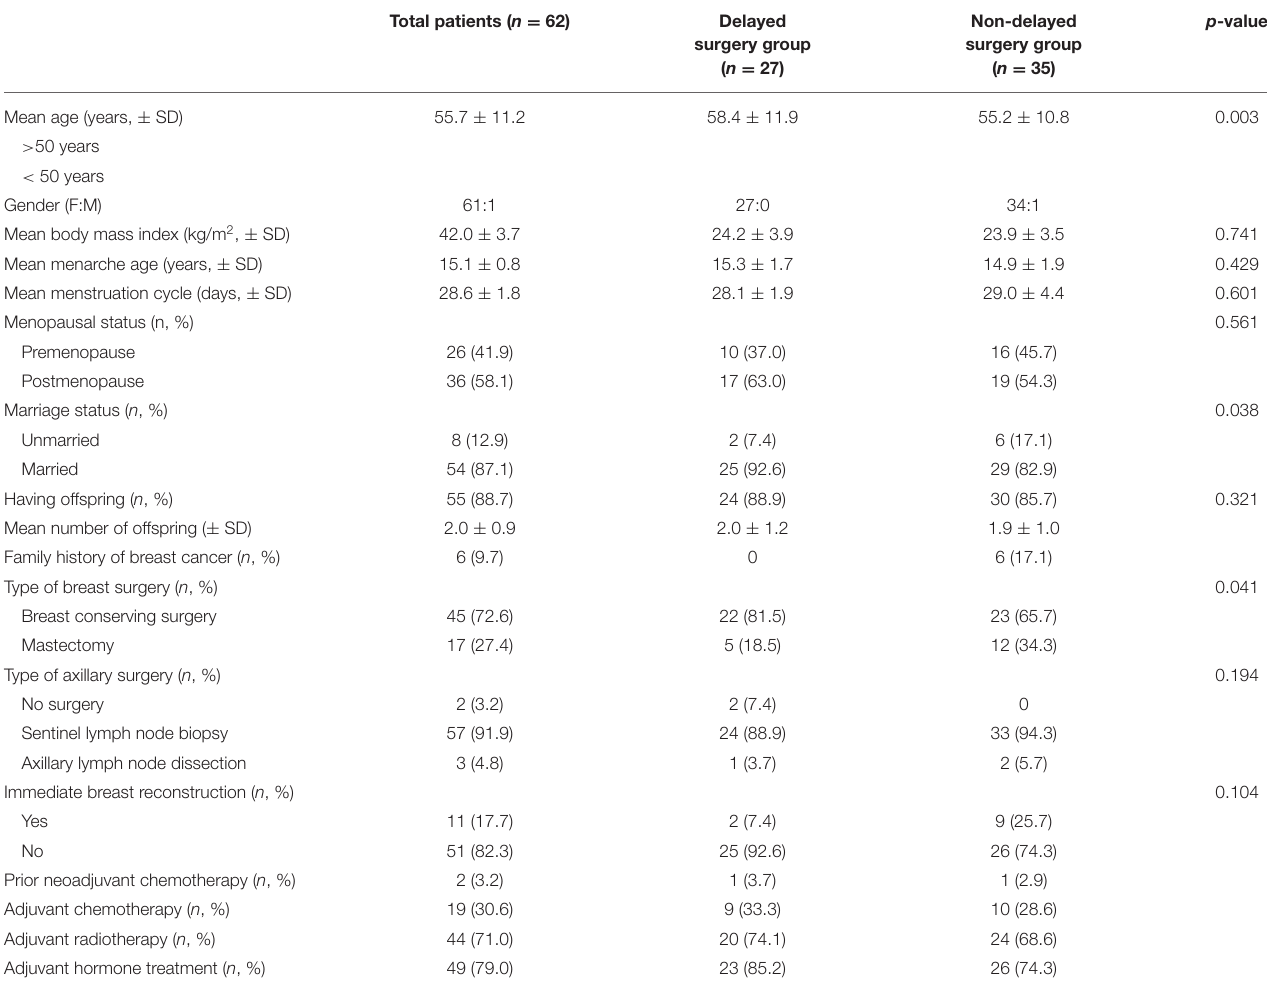
TABLE 1 | Characteristics of patients who underwent surgery during the COVID-19 outbreak. Total patients ( n =